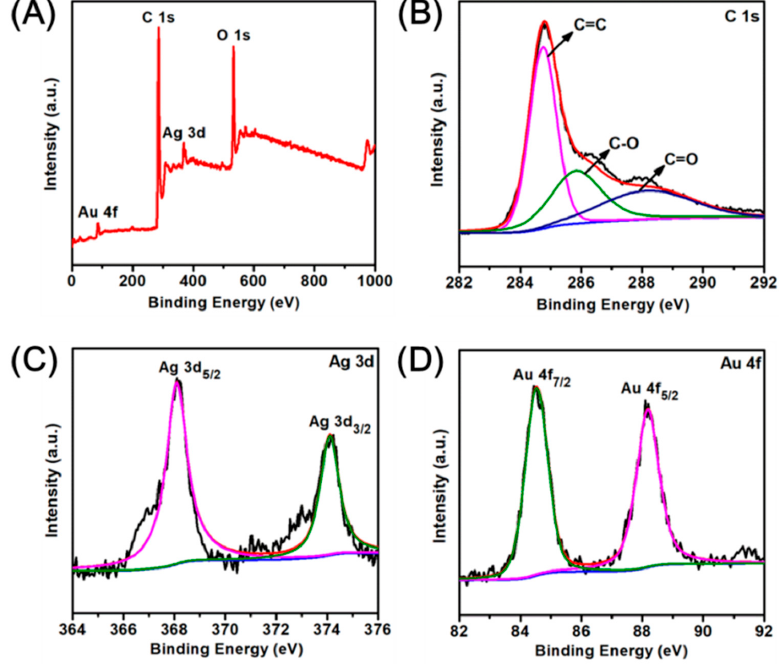
Figure 4. ( A ) X-ray photoelectron spectroscopy (XPS) full scan spectrum of Ag-AuNPs/RGO; ( B – D ) high resolution XPS spectrum for C 1s; Ag 3d; and Au 4f, repectively.